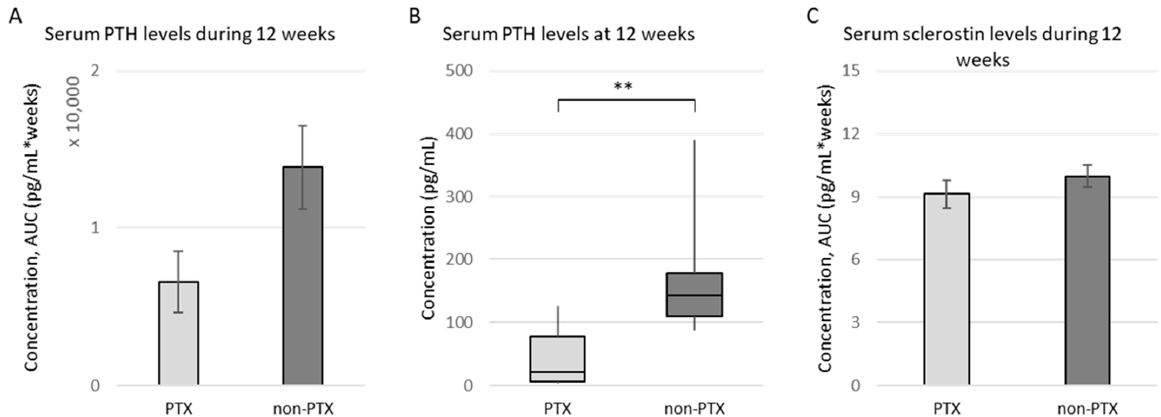
Figure 1. Serum iPTH and sclerostin levels. Serum iPTH and sclerostin levels were measured in PTX rats ( n = 10) and non-PTX rats ( n = 9) using specific enzyme-linked immunosorbent assays (ELISA). ( A ) Total exposure of the bone to iPTH during the 12 weeks of the study (measured as area under the curve (AUC), pg/mL * weeks); ( B ) Serum iPTH levels at 12 weeks (shown as median ± IQR); ( C ) Total exposure of the bone to sclerosin during the 12 weeks of the study (measured as AUC, pg/mL * weeks). ** p ≤ 0.01.